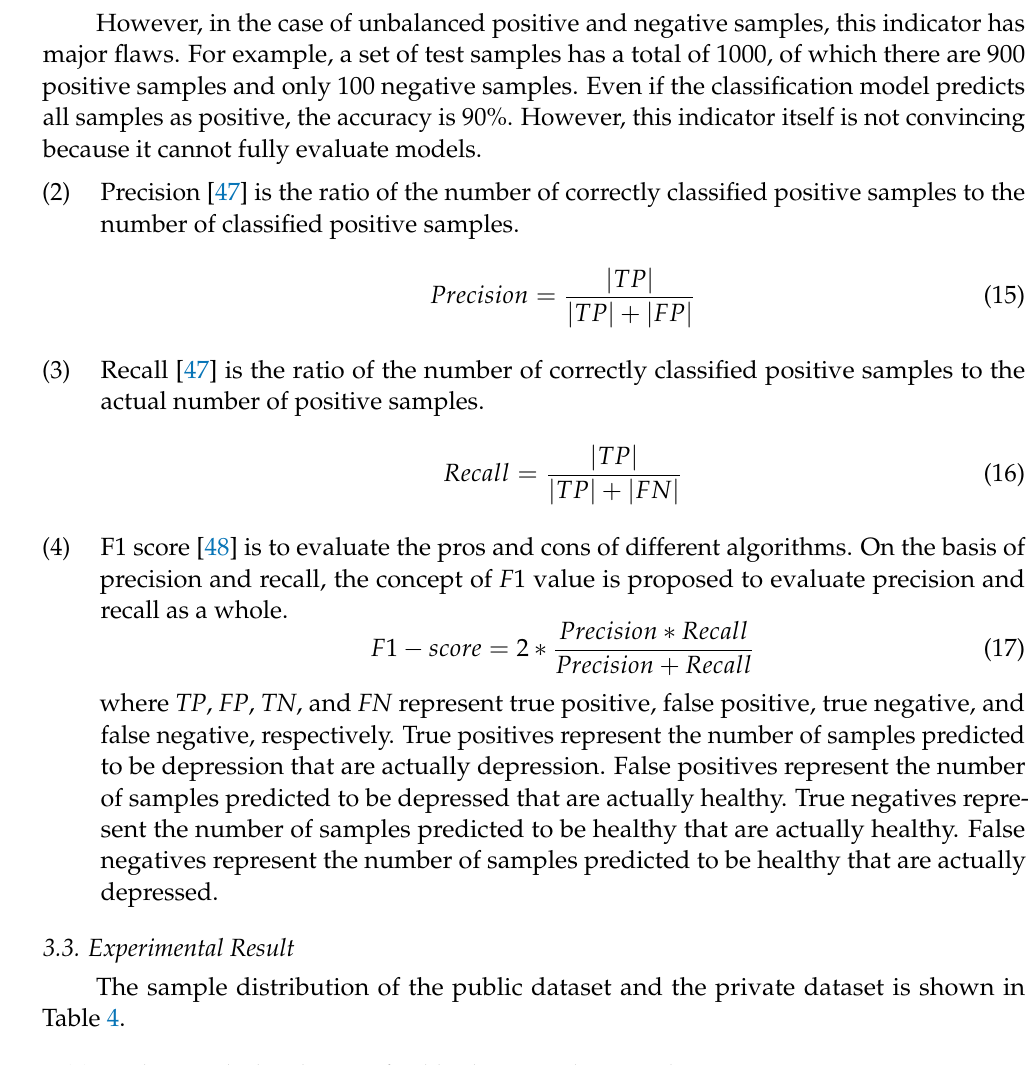
Table 4. The sample distribution of public dataset and private